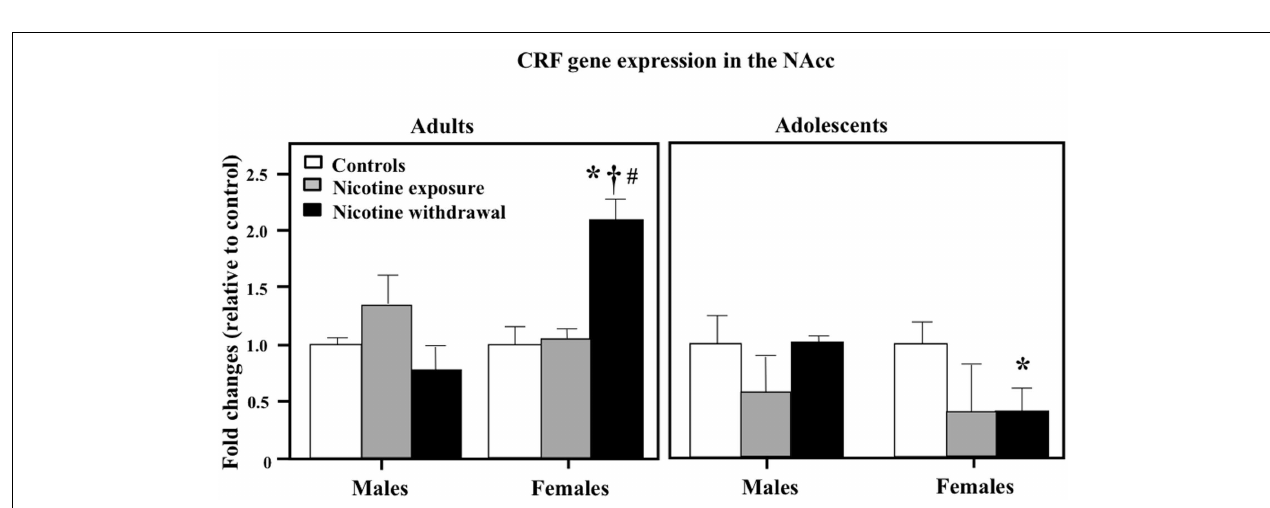
FIGURE 4 | Plasma corticosterone levels during nicotine exposure and withdrawal in adult male (control n = 7; nicotine exposure n = 9; nicotine withdrawal n = 6), adult female (control n = 8; nicotine exposure n = 8; nicotine withdrawal n = 8), adolescent male (control n = 6; nicotine exposure n = 5; nicotine withdrawal n = 5), and adolescent female